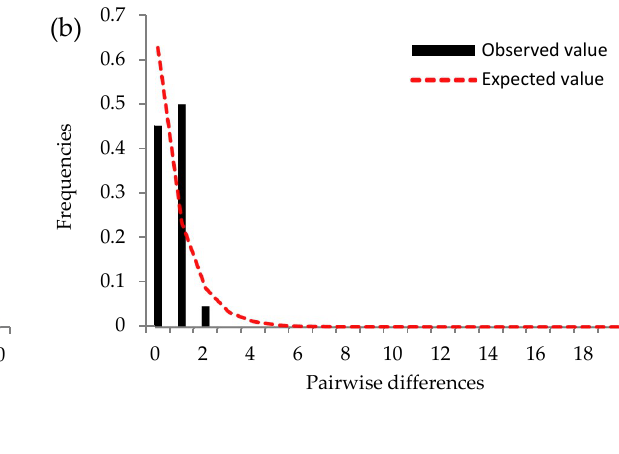
Figure 8. Mismatch distributions of pairwise nucleotide differences between individuals of R. maidis and R. padi . ( a ) Combined COI−COII gene of R. maidis ; ( b ) EF−1α gene of R. maidis ; ( c ) combined COI−COII gene of R. padi ; ( d ) EF−1α gene of R. padi . The numbers of pairwise differences are on the x−axis and their frequencies are on the y−axis. 4. Discussion 4.1. Genetic Diversity and Sequence Variation This is the first study of the genetic diversity of R. padi collected from maize in most of the maize−growing regions in China as well as Europe. Knowledge about the genetic diversity of R. maidis has been so far limited to two studies based on an allozyme analy- sis of North American populations, which showed regional differentiation [43], and Ca- nadian populations, which demonstrated low genetic diversity [21]. Our results revealed that R. maidis exhibited low genetic differentiation among populations. The genetic di- versity of R. padi was overall higher than that of R. maidis particularly for the combined